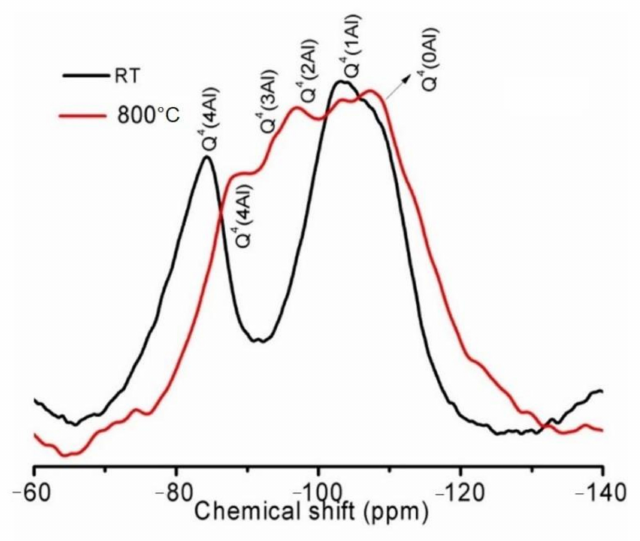
Figure 8. NMR analysis of geopolymer composites